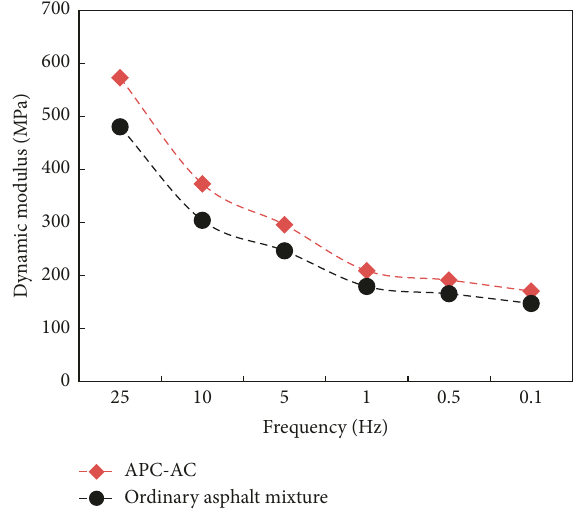
Figure 17: Results of dynamic modulus tests at 60 ° C.